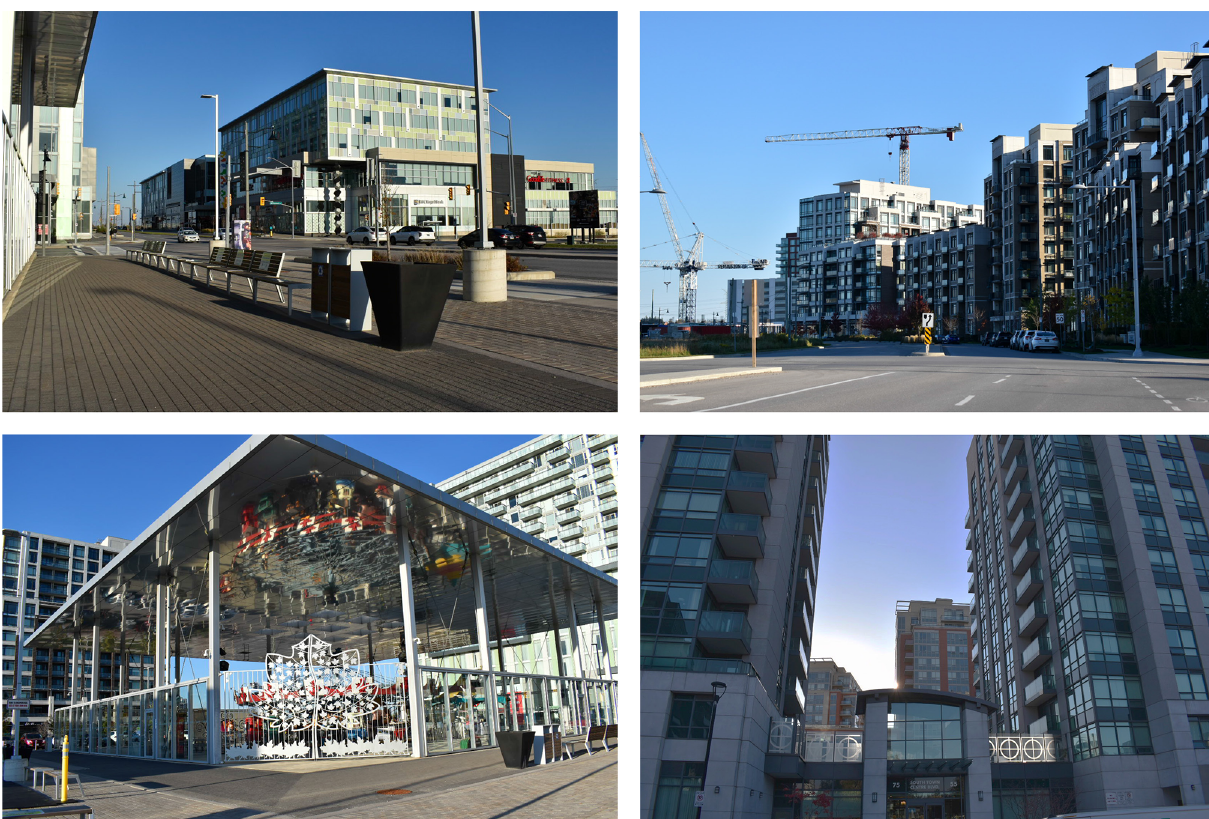
Figure 9. Markham Centre. Source: Author. New urbanism is still sort of there. I mean new urban- ism isn’t rocket science. It’s building real cities, as they were always built: Street-related buildings, grid pat- tern streets, a very strong sense of the public realm. And really whether the buildings are low-rise build- ings or mid-rise buildings or taller buildings, the prin- ciples are all the same….Our focus clearly is on public transit. (P04) Table 2. Cornell and Markham Centre policy discourse examples. Cornell Markham